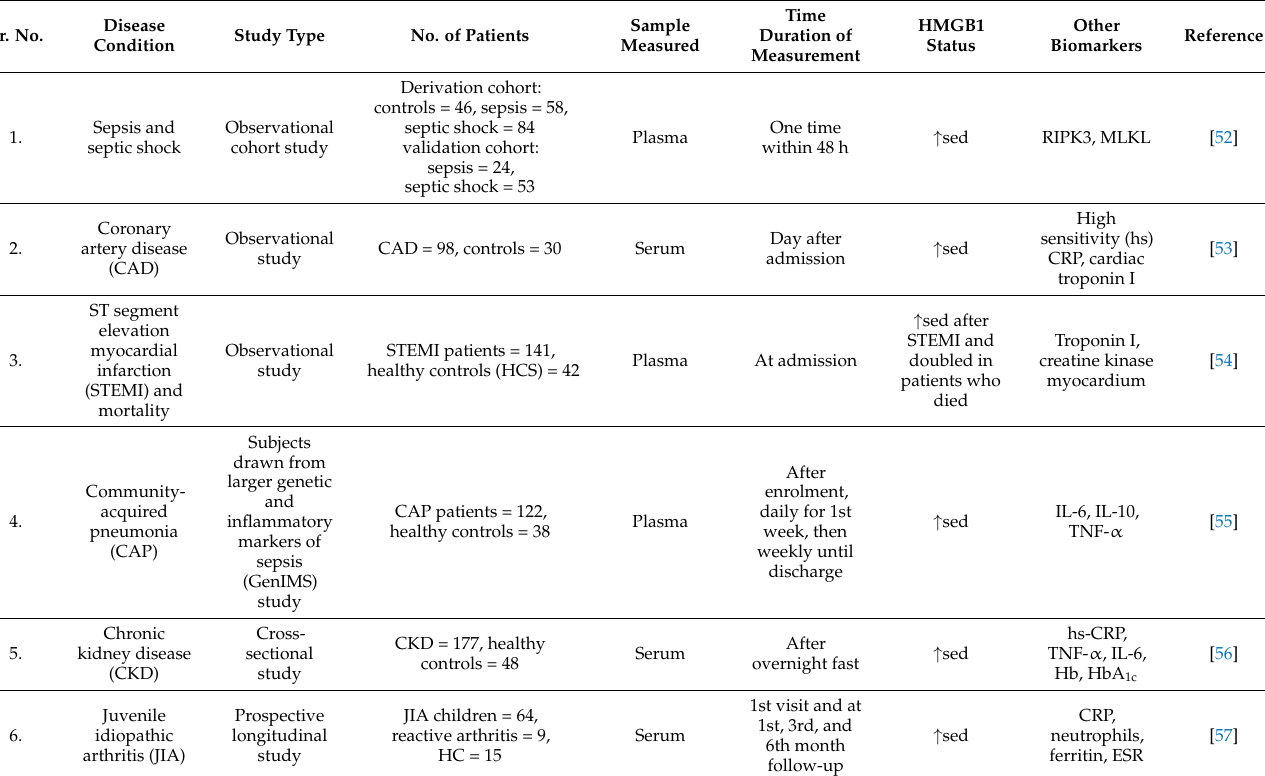
Table 1. List of different diseases in which HMGB1 levels are